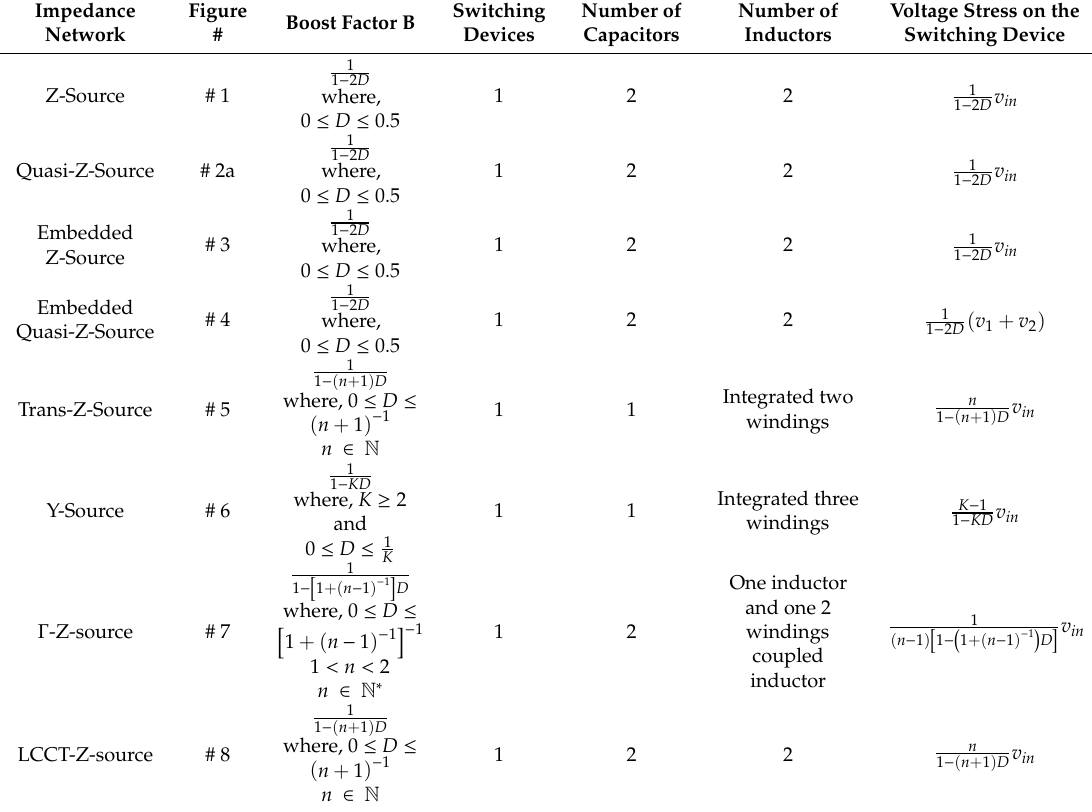
Table 1. Summary of the impedance source network